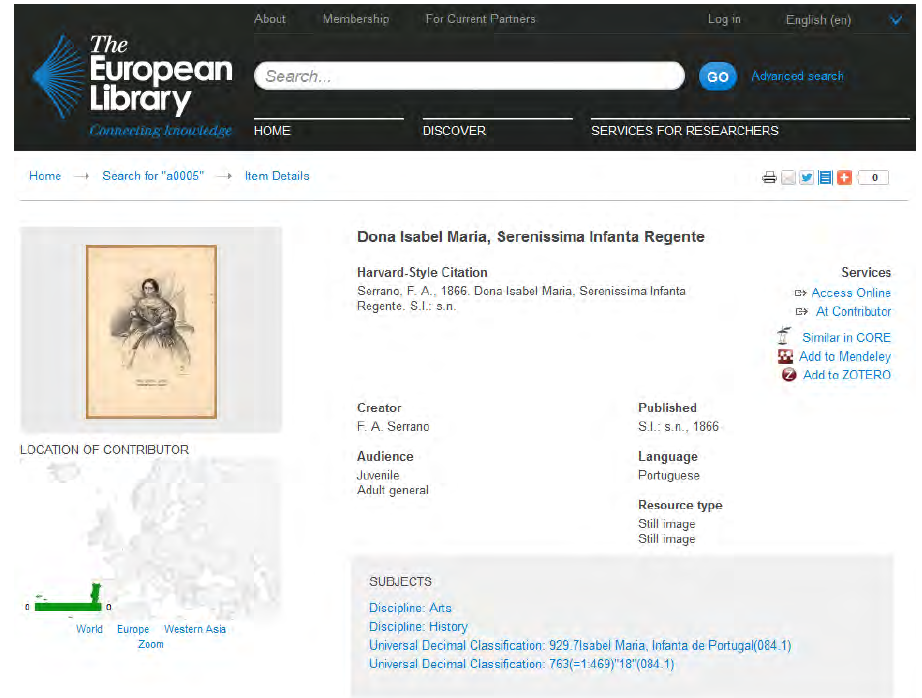
Fig 3: Alignment of bibliographical records with CERIF in The European Library